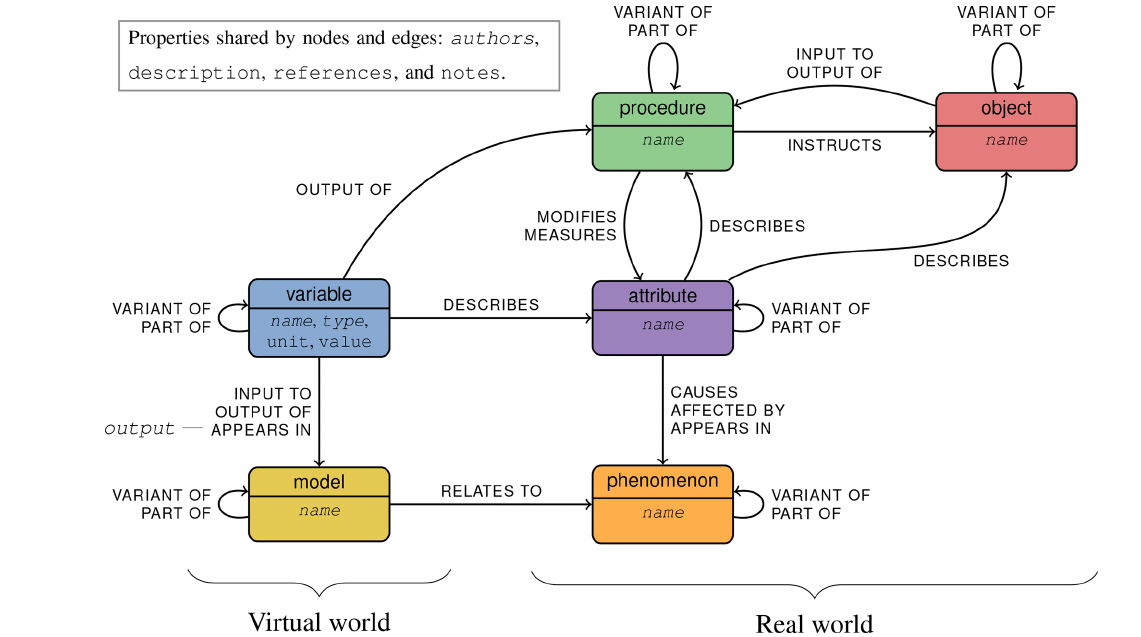
Figure 2. A schematic overview of the categories, relationships, and ( required ) properties defined by the database schema. Table 1. Example concepts for each of the categories